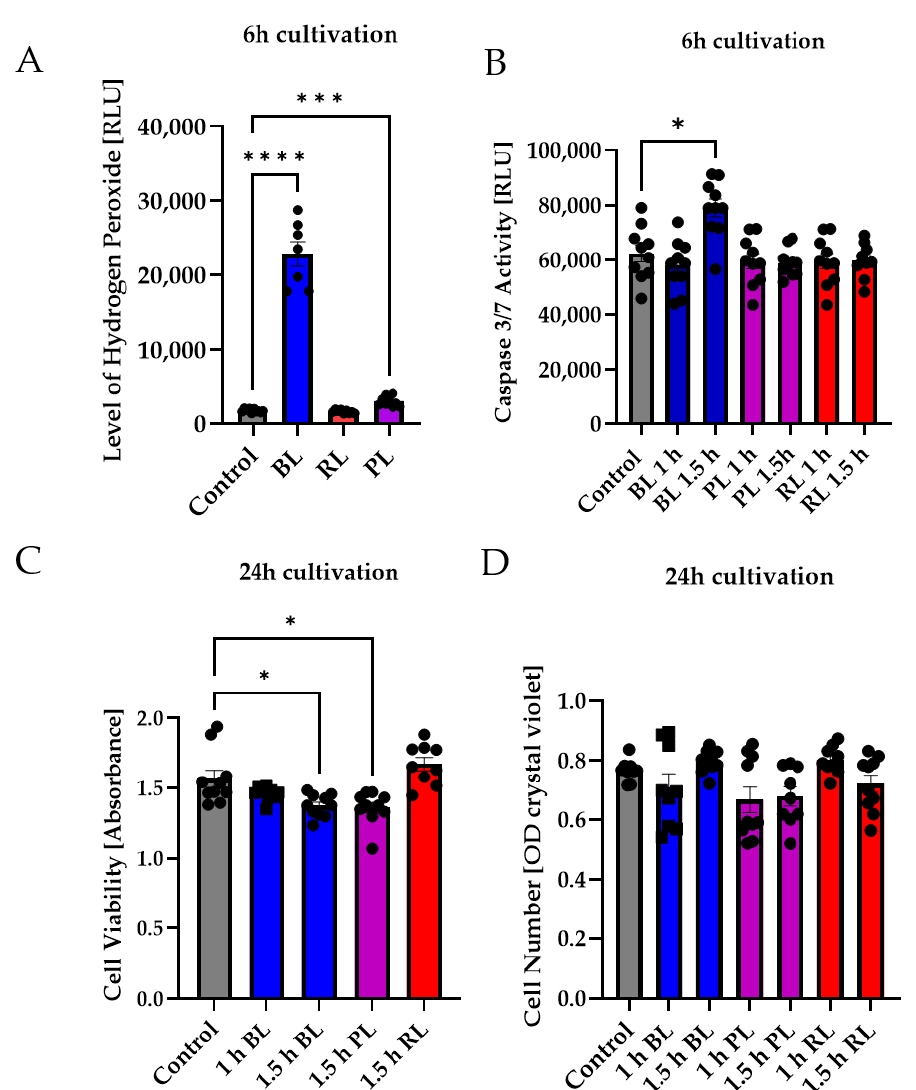
Figure 4. Neither purple nor red light exposure strongly affected MIO-M1 cells. Human MIO-M1 cells were exposed to blue (BL), purple (PL), or red light (RL) for 1.5 h and further cultured for 6 or 24 h. ( A ) Oxidative stress levels were significantly induced 6 h after BL or PL exposure, but not after RL exposure. ( B ) Only BL exposure led to significantly increased caspase 3/7 activity in MIO-M1 cells 6 h after exposure. ( C ) Cell viability was slightly but significantly decreased 24 h after 1.5 h of BL or PL exposure. ( D ) BL, PL, and RL exposure did not alter cell numbers 24 h after exposure. Bar graphs represent the mean values and SEM. The experiments were repeated three times with similar results. Statistical differences are indicated as follows: * p < 0.05, *** p < 0.001, and **** p < 0.0001 compared to control, according to Welch’s one-way ANOVA or Kruskal–Wallis test. Taken together, BL increased oxidative stress levels in MIO-M1 cells, but PL exposure only slightly induced oxidative stress levels and was, therefore, not able to alter caspase 3/7 activity, cell viability, or cell density (Figure 4). RL exposure did not affect MIO-M1 cells at all (Figure 4). In summary, MIO-M1 cells did not react as primary MCs to our applied exposure. Because MIO-M1 cells generally demonstrated a very slight effect, only investigations on porcine MCs were performed